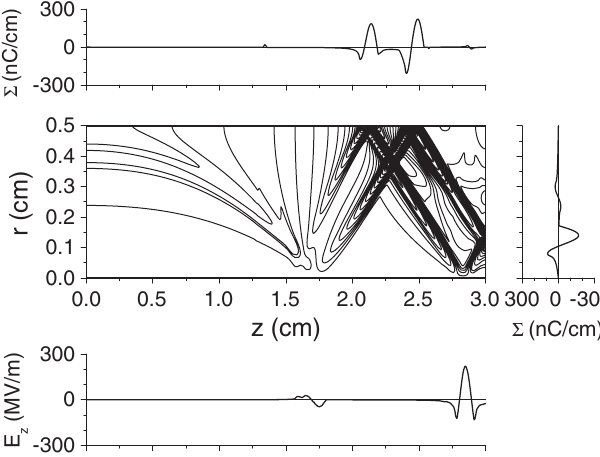
FIG. 6. Flux lines, axial electric field on the beam axis, and the lineal surface charge density of the wakefield in the dielectric- ¼ 2 d . filled cavity when z b